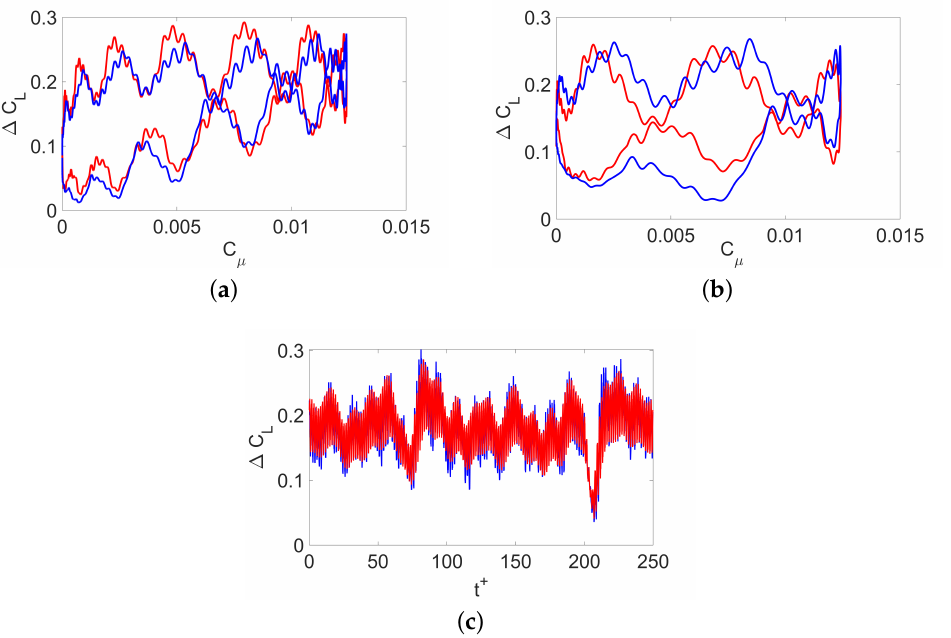
Figure 9. The comparison between the hybrid model and experimental data. ( a ) k = 0.128, ( b ) k = 0.25 and ( c )